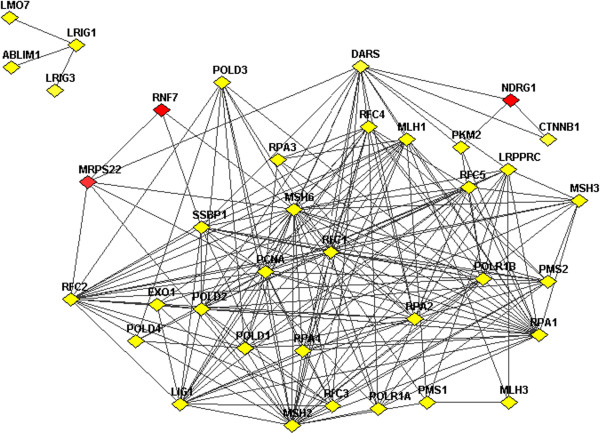
Network links between 23 genes in pathway of mismatch repair and three driver genes. Network links between 23 genes in pathway of mismatch repair and driver genes MRPS22, NDRG1, RNF7. Links shown include physical interactions, metabolic and signaling links from the functional coupling network (http://FunCoup.sbc.su.se).